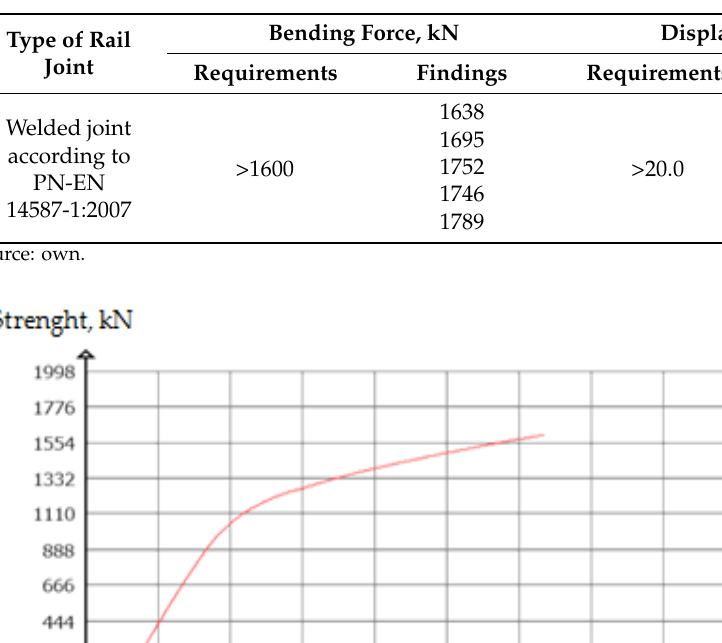
Table 6. Obtained bending test results of welded rail joints.